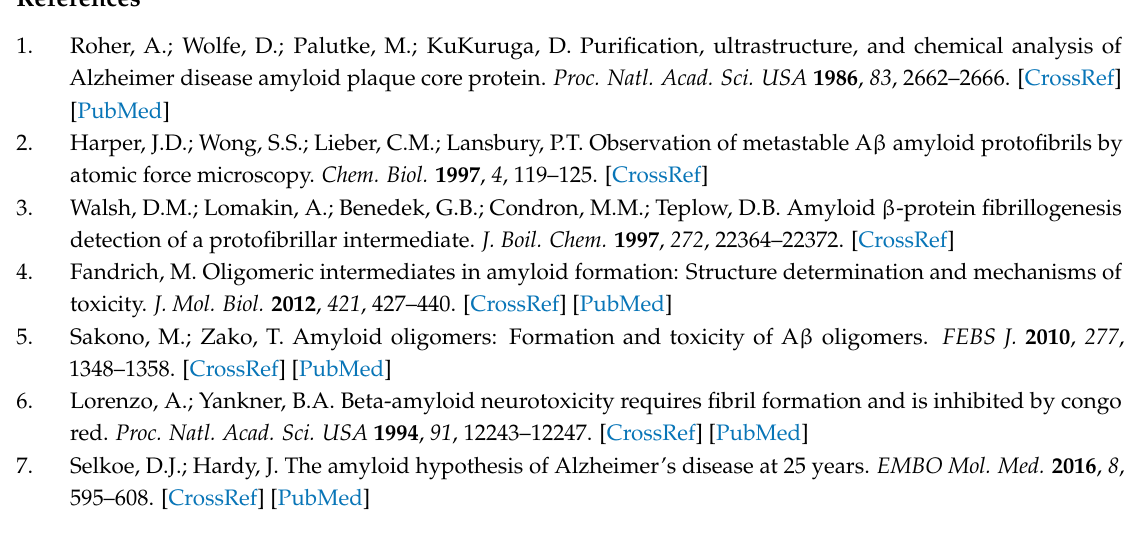
Figure S1: Electropherograms of un-incubated A β 1-40 initially dissolved in Ringer, Figure S2: Electropherograms of un-incubated A β 1-40 initially dissolved in NH 4 OH and of un-incubated Ringer, Figure S3: Kinetic of the incubation of A β 1-40, Figure S4: Photographs of rubber stoppers for the vials, Figure S5: Successive analysis of 30 kDa ultra-filtered Ringer using “open stoppers” on sample and buffer vials, Figure S6: Effect of injection volume on the width of peaks and spikes, Figure S7: Effect of nature of running buffer on the separation of incubated A β 1-40, Figure S8: Effect of sonication on the capillary electrophoresis of incubated A β 1-40, Figure S9: Analysis of incubated A β 1-40 or ultra-filtered Ringer using a running buffer devoid of thioflavine T, Figure S10: Effect of nature of the running buffer on basal fluorescence and on its decay according to time, Figure S11: Effect of decreasing the contact time between analyte and thioflavine T on the capillary electrophoresis of incubated A β 1-40, Figure S12: Effect of size of electrokinetically injected sample on the number of